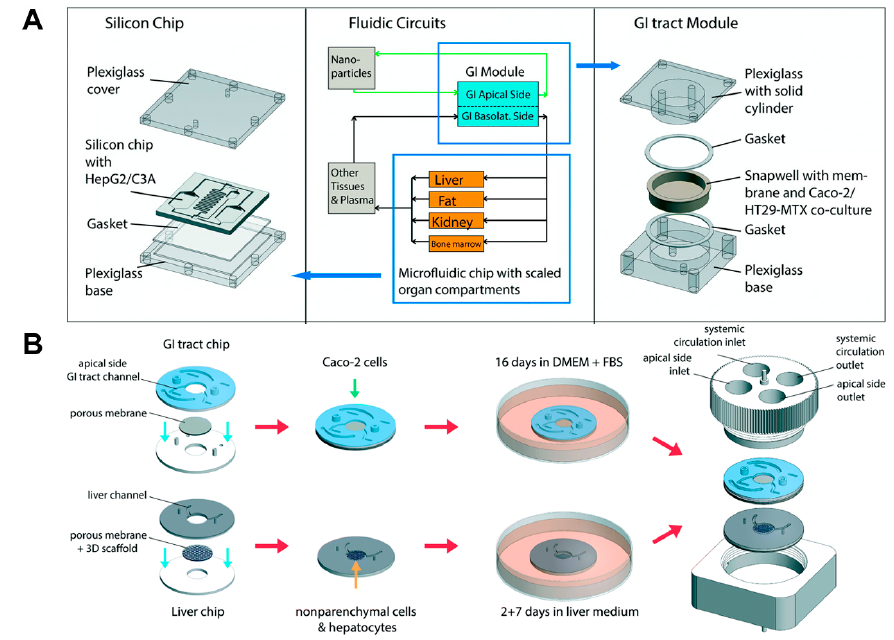
Figure 2. First pass metabolism models based on co-culture with organ-specific cells. ( A ) The GI tract module and the body-on-a-chip system where Caco-2 and HT29-MTX cells were co-cultured and connected with HepG2 cells. Image reprinted from [31] with the permission of The Royal Society of Chemistry. ( B ) Modular, pumpless body-on-a-chip system where Caco-2 cells were cultured on the GI tract chip, and hepatocyte and non-parenchymal cells were co-cultured on the liver chip, respectively. Then, each module was connected to simulate first pass metabolism. Image reprinted from [39] with the permission of The Royal Society of Chemistry.